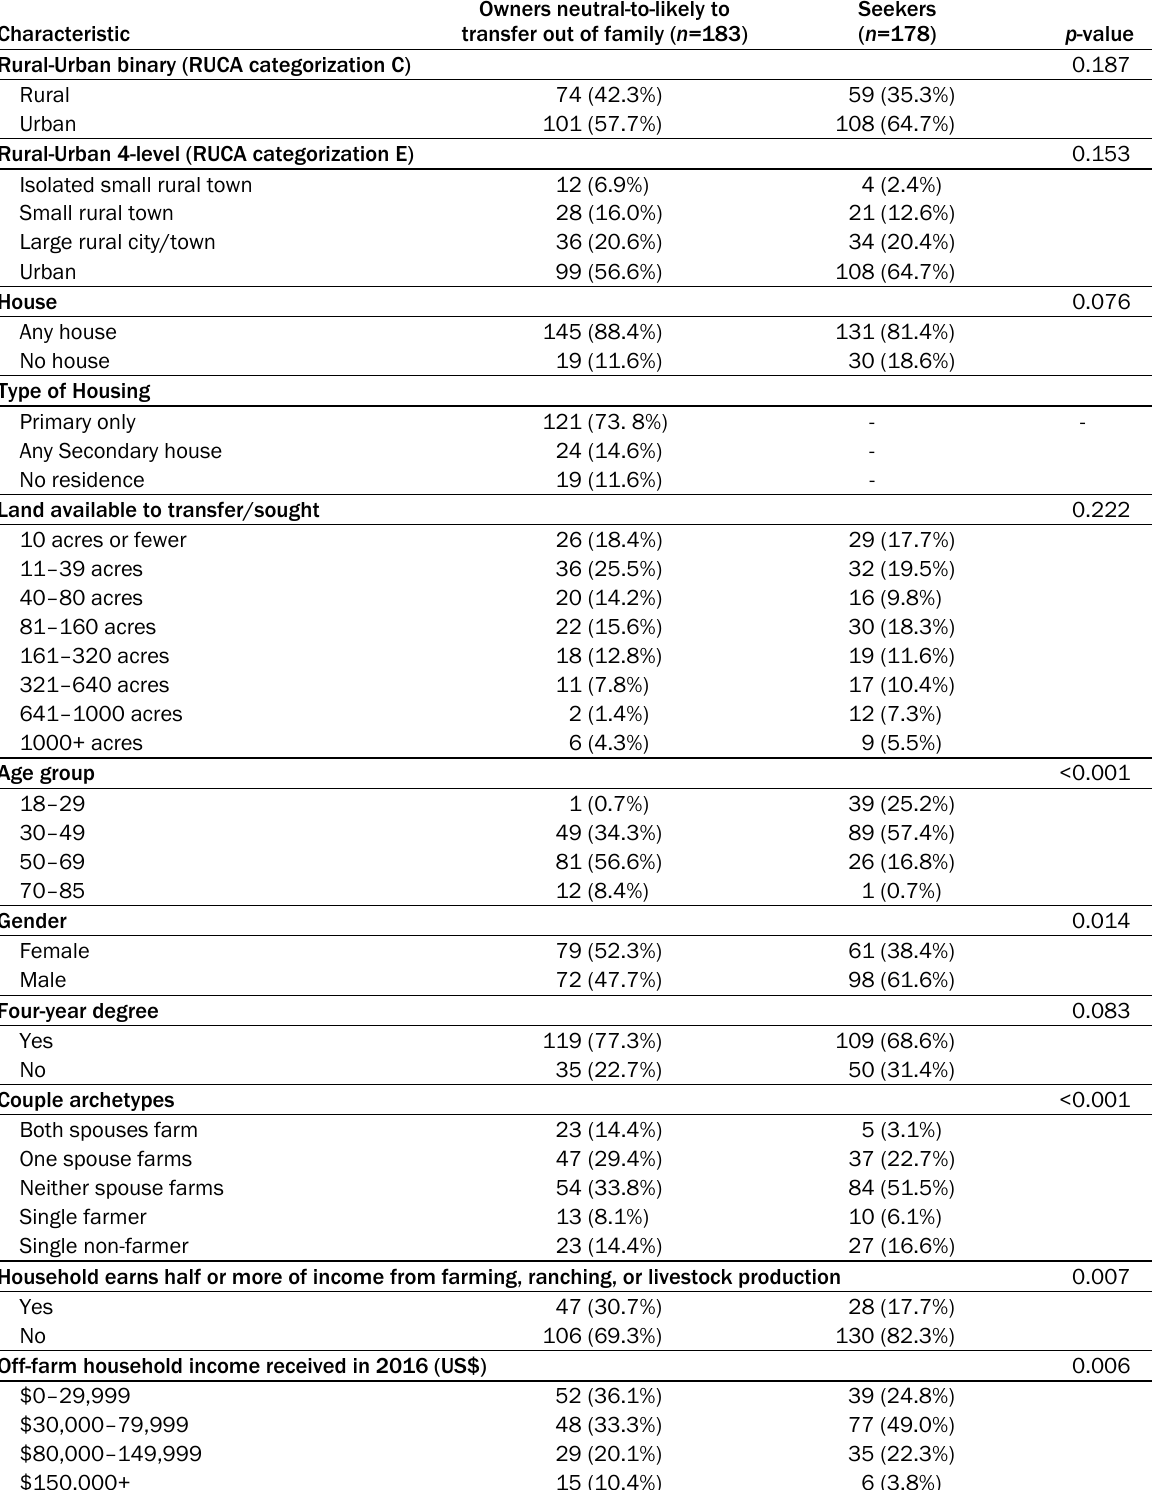
Table 2. Online Survey Responses: Seeker and Owner Characteristics and Results of Chi-Squared Tests Owners neutral-to-likely Characteristic